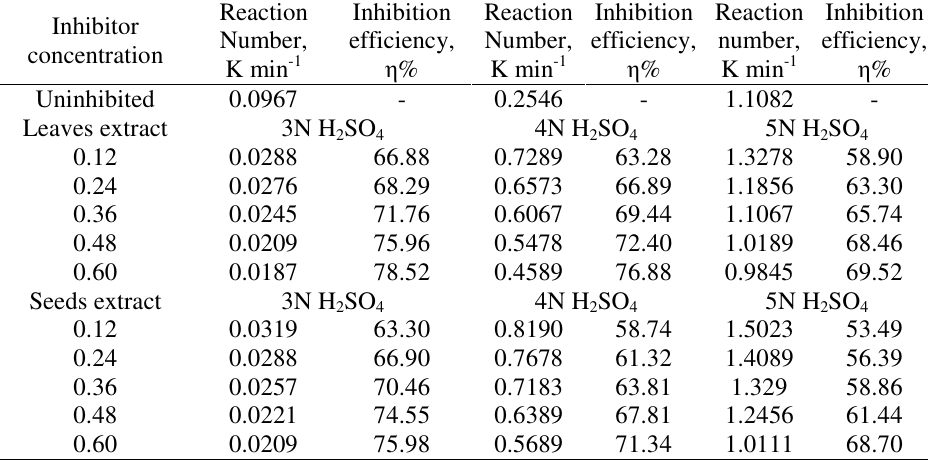
Table 3. Reaction number (RN) and percentage inhibition efficiency ( η %) for aluminium in H SO solution with given inhibitor extract at 298 2 4